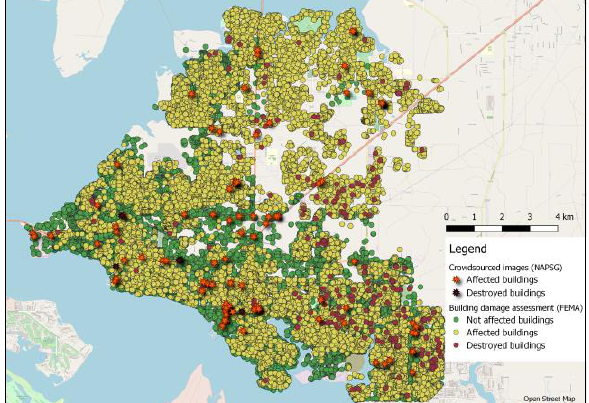
Figure 2. Spatial distribution of building damage and crowdsourced photos over the Panama